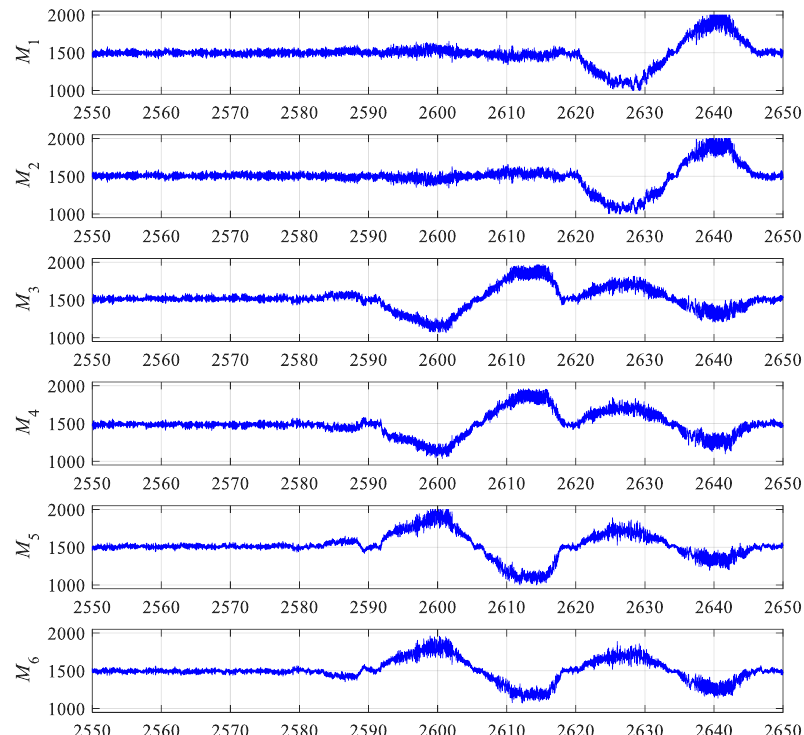
Figure 11. PWM signals sent by FC aircraft in case of PTX6 functionality testing.